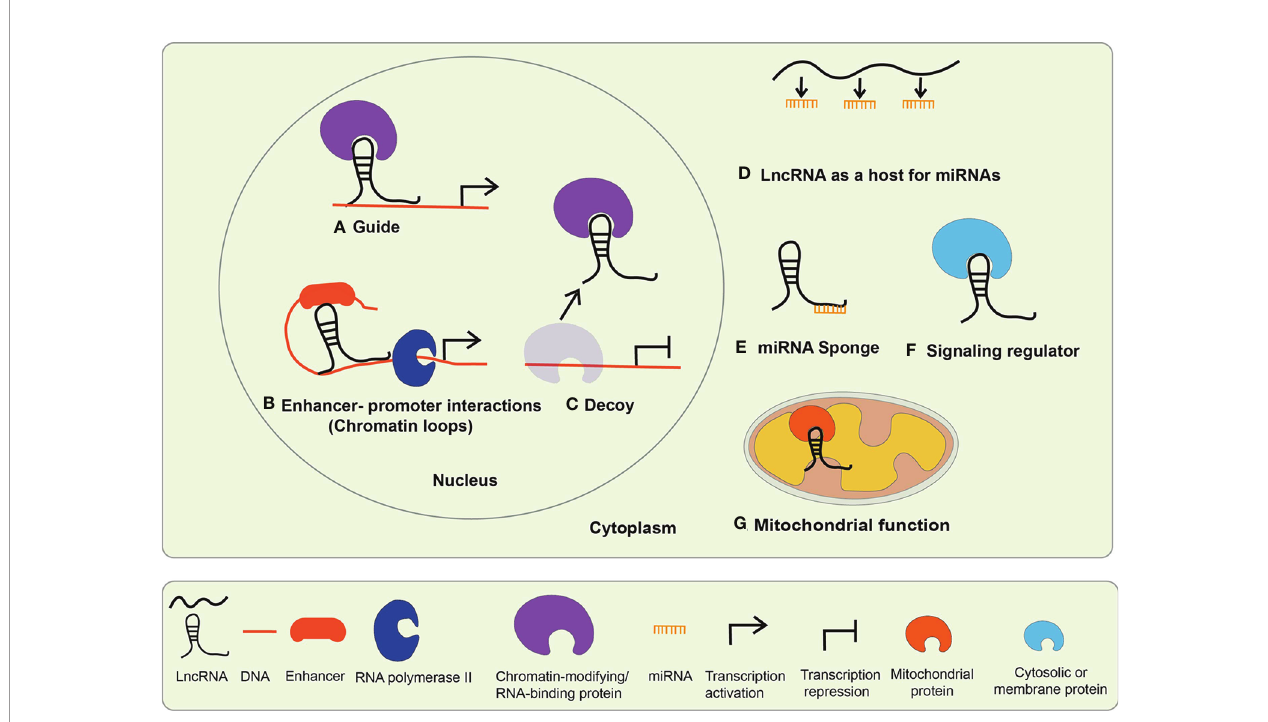
FIGURE 2 | Mechanisms of lncRNA mediated gene regulation. The mechanisms of lncRNA actions are dependent upon their subcellular localization. LncRNAs localized in the nucleus mediate transcriptional regulation, whereas those located in the cytoplasm regulate via post-transcriptional mechanisms. Nuclear lncRNAs regulate transcription by (A) acting as guide lncRNAs that interact with chromatin-modifying and RNA-binding proteins to facilitate their recruitment on regulatory DNA sequences to activate or repress gene expression; (B) mediating enhancer promoter interactions-LncRNAs promote long-range enhancer-promoter interactions via chromatin looping; (C) acting as decoys that interact with the regulatory proteins to sequester them and prevent their normal functions. Cytosolic lncRNA mechanism of action includes: (D) serving as host genes for miRNAs, i.e. they harbor miRNAs within their exonic or intronic sequences; (E) acting as miRNA Sponges or competitive endogenous RNA (ceRNA)s, compete with mRNAs for shared complementary miRNA binding sites; (F) interacting with cytosolic or membrane proteins to regulate their functions and signaling processes; (G) serving as mitochondrial protein activators-lncRNAs interact with key mitochondrial proteins to modulate mitochondrial functions such as fatty acid